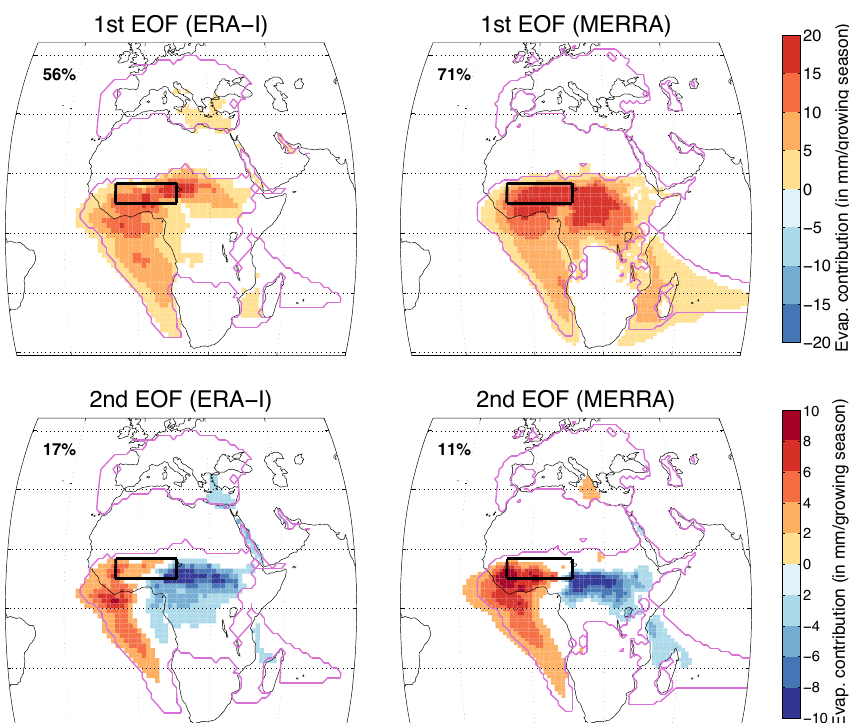
Fig. 6. Comparison of first and second EOFs for the Western Sahel (ERA-Interim on left and MERRA on right ), for the period 1980-2011. Figure 6. Comparison of first and second EOFs for the western Sahel (ERA-Interim on left and MERRA on right), for the period 1980– The magenta line indicates the 5mm growing season  1 precipitationshed boundary, the black box indicates the sink region, and the bold 2011. The magenta line indicates the 5mmgrowingseason − 1 precipitationshed boundary, the black box indicates the sink region, and numberintheupperleftcornerindicatestheamountofvarianceexplainedbytheassociatedpattern.Wedonotshowvalues < 2mmgrowing season  1 , for the sake of clarity in the figure. the bold number in the upper left corner indicates the amount of variance explained by the associated pattern. We do not show values <2mmgrowingseason − 1 , for the sake of clarity in the